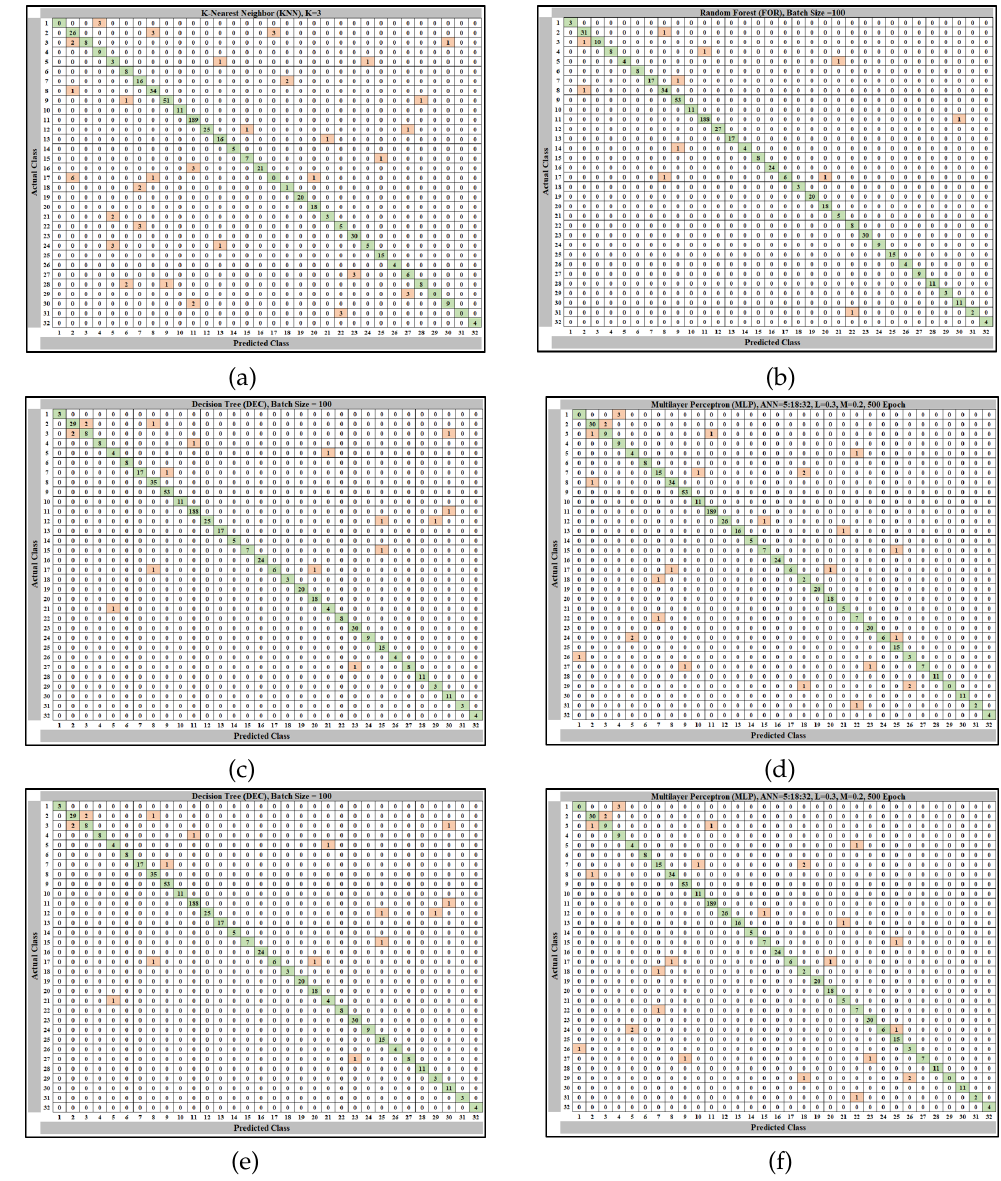
Figure 14. The confusion matrices resulting from the six trialed algorithms: ( a ) K-Nearest Neighbor, ( b ) Random Forest, ( c ) Random Tree, ( d ) Reduced Error Pruning (REP) Tree, ( e ) Decision Tree, and ( f ) Multilayer Perceptron.